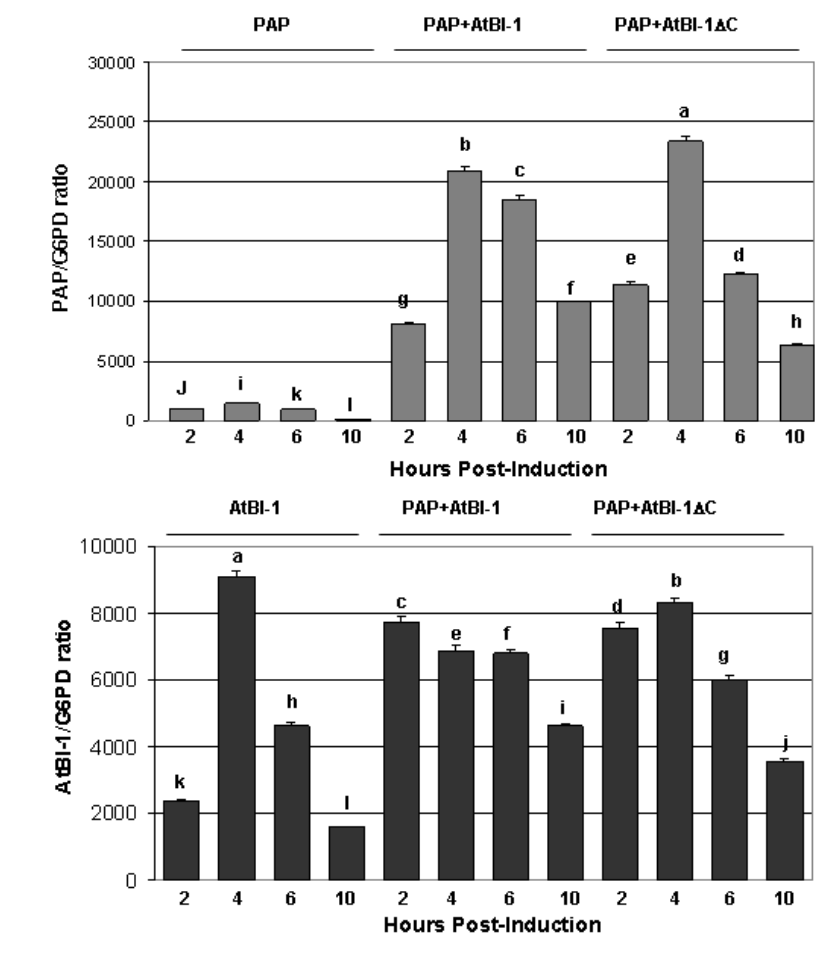
FIGURE 6 : Real-time PCR analysis of mRNA levels in yeast cells. (A) Analysis of PAP mRNA in yeast cells expressing AtBI-1. (B) Analysis of AtBI-1 mRNA in yeast cells express- ing PAP. Cells were grown on galac- tose for the hours indicated. The mRNA levels for the genes were normalized to G6PD mRNA using the ΔΔCT method from Applied Biosystems. The results represent three independent experiments. Columns are statistically different according to ANOVA (P < 0.001) followed by a post-hoc Fisher's Least Significant Difference (LSD)